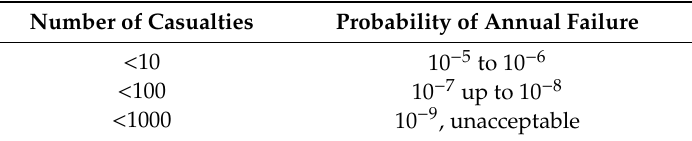
Table 5. Annual probabilities of failure according to nautical and aeronautical industries, adapted from